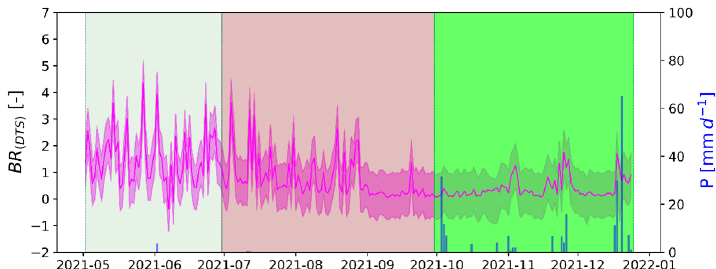
Figure A2. Estimated daily diurnal (06:00–18:00LT) Bowen ratio for May to December 2021 at the Mpika miombo woodland study site. The shaded area for Bowen ratio is the standard deviation. The shaded area for dates is the phenophase (senescence/green-down: May–June, dormant: July–September, green-up: October–December).